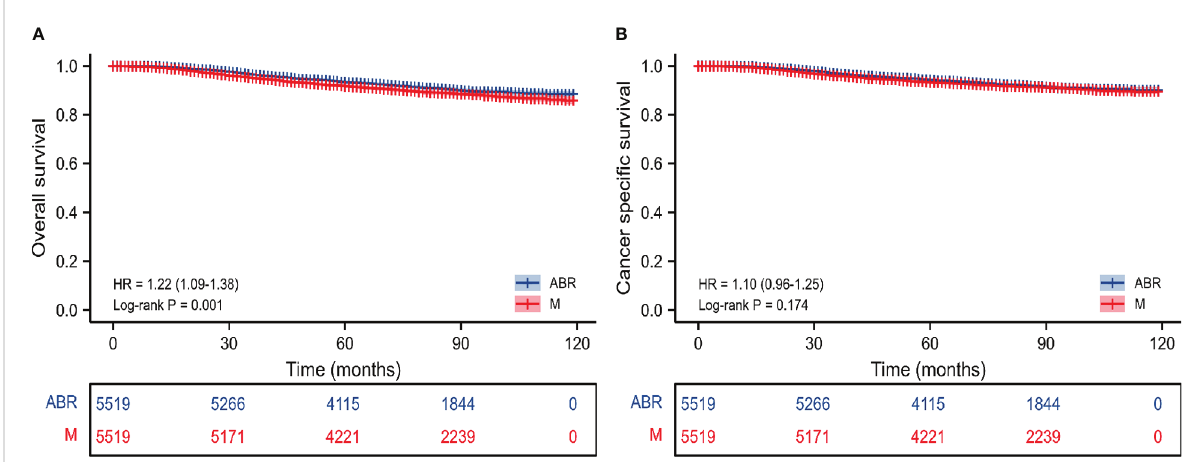
FIGURE 2 Kaplan-Meier survival curves of survival analysis on OS (A) and CSS (B) after PSM in the entire cohort. M, mastectomy; ABR, autologous breast reconstruction; OS, overall survival; CSS, cancer speci fi c survival.